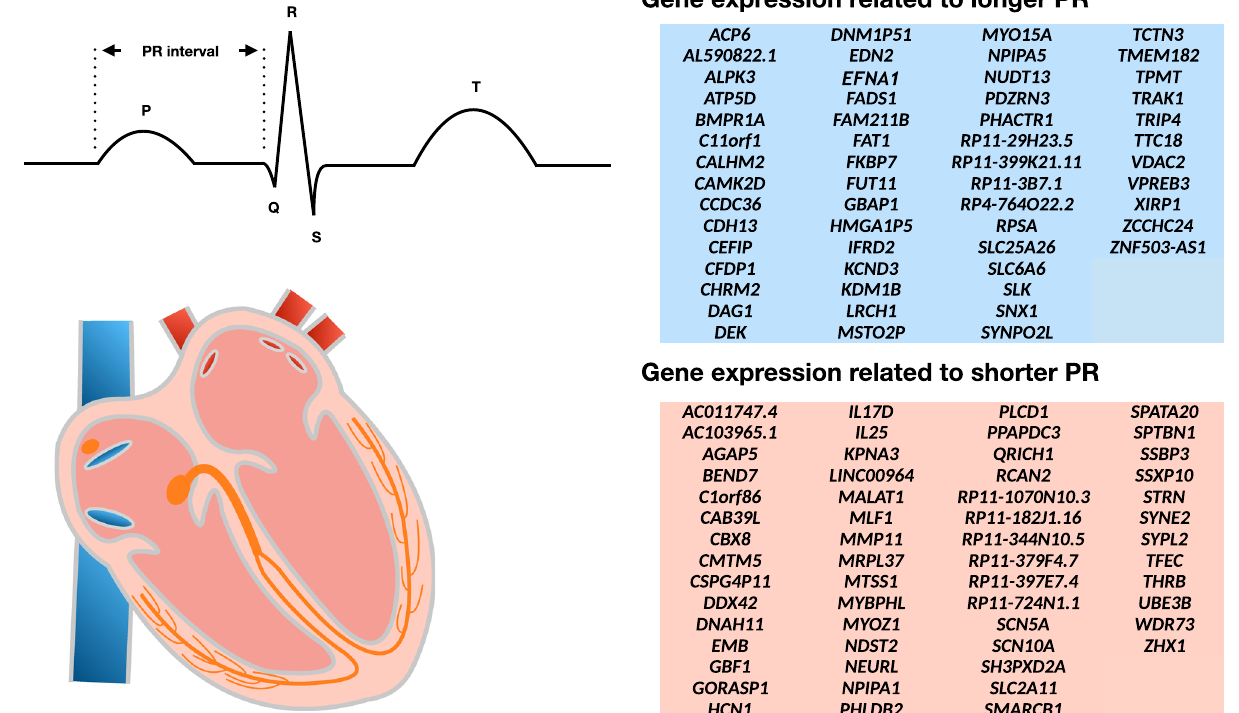
Fig. 3 Plausible candidate genes of PR interval from S-PrediXcan. Diagram of standard electrocardiographic intervals and the heart. The electrocardiographic features are illustratively aligned with the corresponding cardiac conduction system structures (orange) re fl ected on the tracing. The PR interval (labeled) indicates conduction through the atria, atrioventricular node, His bundle, and Purkinje fi bers. Right: Supplementary Data 14 shows 113 genes whose expression in the left ventricle ( N = 233) or right atrial appendage ( N = 231) was associated with PR interval duration in a transcriptome-wide analysis using S-PrediXcan and GTEx v7. Displayed genes include those with signi fi cant associations after Bonferroni correction for all tested genes ( P < 3.1 × 10 − 6 ). Longer PR intervals were associated with increased predicted expression of 56 genes (blue) and reduced expression of 57 genes